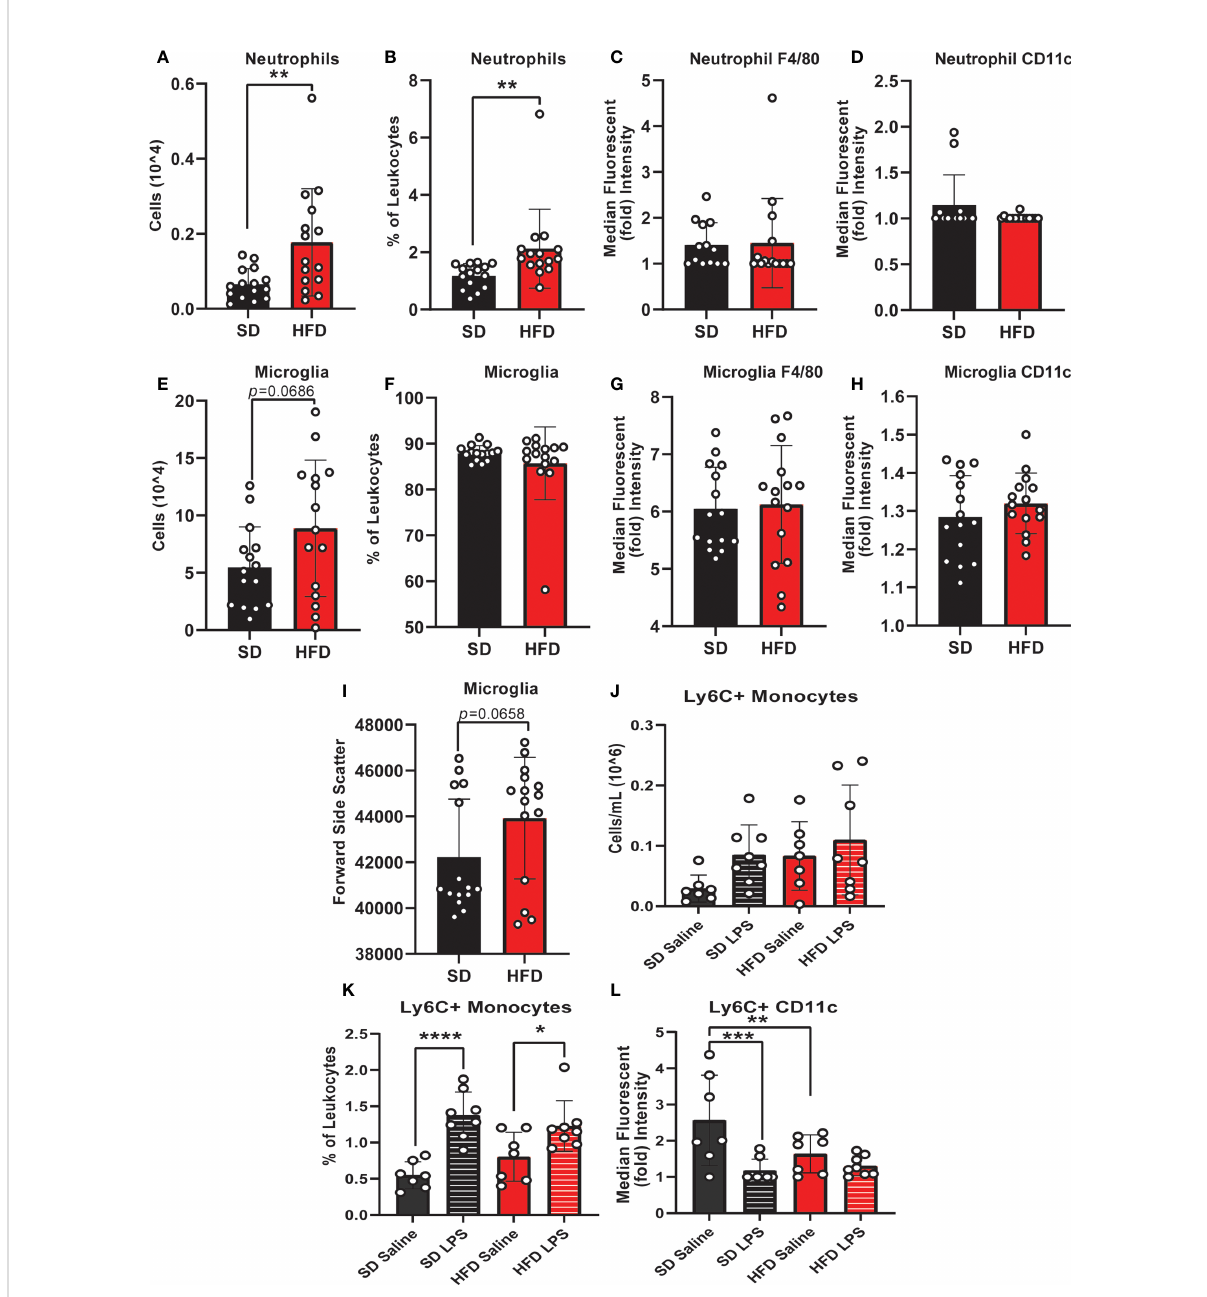
FIGURE 2 CNS immunophenotyping of myeloid cells by fl ow cytometry. Data represented as neutrophils (number of cells, % of cells, F4/80 expression, and CD11c expression; A-D ), microglia (number of cells, % of cells, F4/80 expression, CD11c expression, and forward side scatter; E-I ), and Ly6C + monocytes (number of cells, % of cells, and CD11c expression; J-L ) in male BL/6 mice fed standard diet (SD) or high fat diet (HFD) who were administered saline or LPS (lipopolysaccharide). In the absence of differences between saline and LPS, data for each dietary group were combined and are presented as SD vs. HFD alone; * p <0.05, ** p <0.01, *** p <0.001, **** p